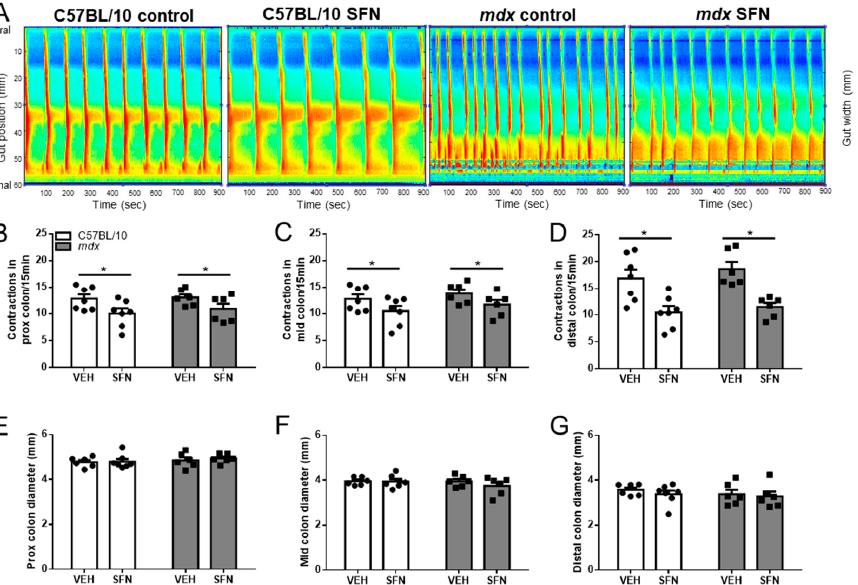
Figure 1. Ex vivo SFN treatment reduces contraction number in the distal colon . ( A ) Colons were excised from eight-week-old male C57BL/10 and mdx mice to assess ex vivo contraction by video recording and ST mapping of colon diameter during a control period (4 × 15 min; VEH) and subsequently in the presence of 5 µ M SFN (4 × 15 min; SFN). Contraction frequency (number of